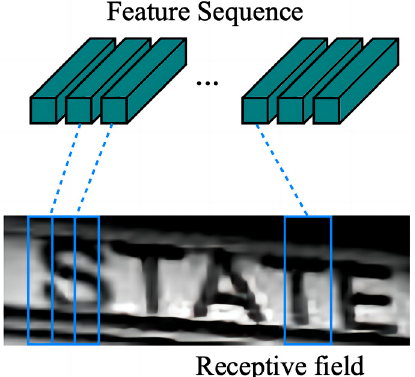
and then converted into labels using per-frame prediction in the recurrent layer. The